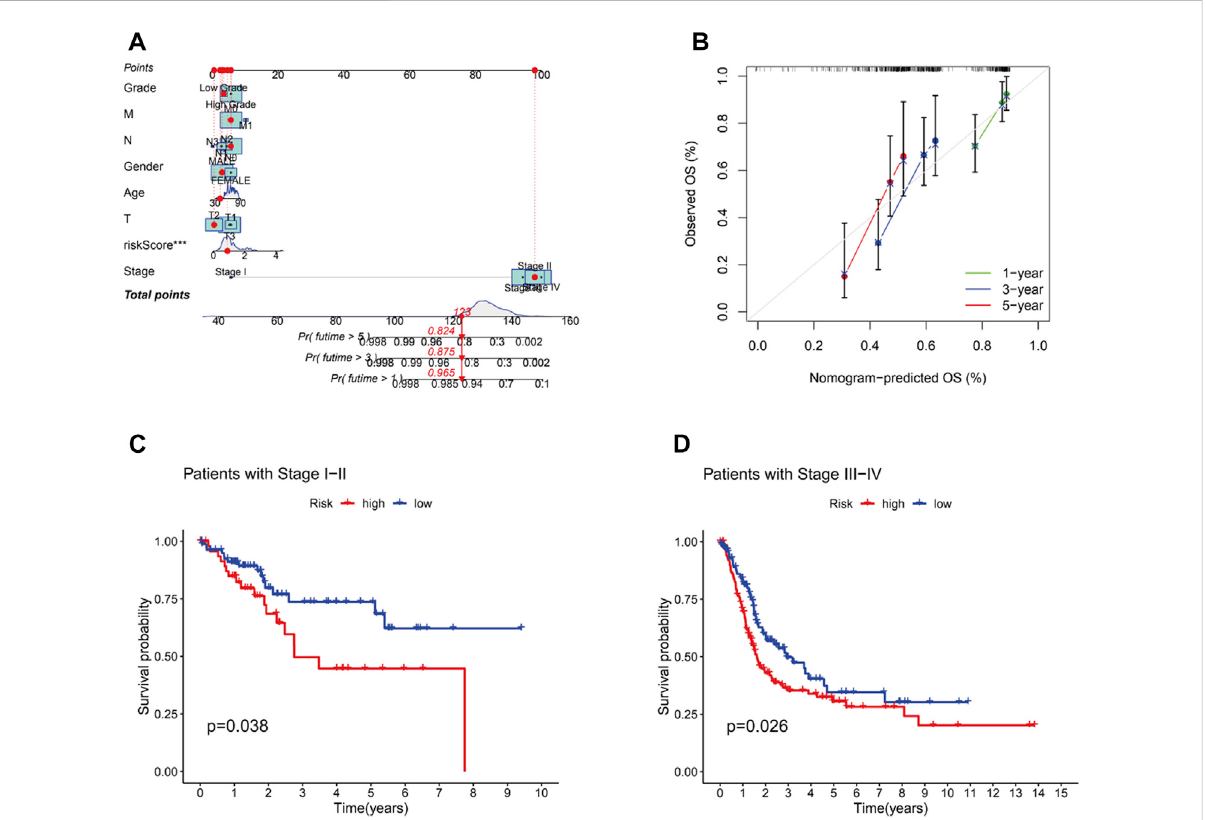
The construction of nomogram and the predictive outcomes of clinical subgroups. (A) .The combined nomogram for the risk model and other clinicopathologicalfactors. (B) .Calibrationcurves of1-,3-, and5-year.The highandlowriskgroups wereextimatedtoanalyzethesurvivalin fl uence at stage Ⅰ - Ⅱ (C) and stage Ⅲ - Ⅳ (D)